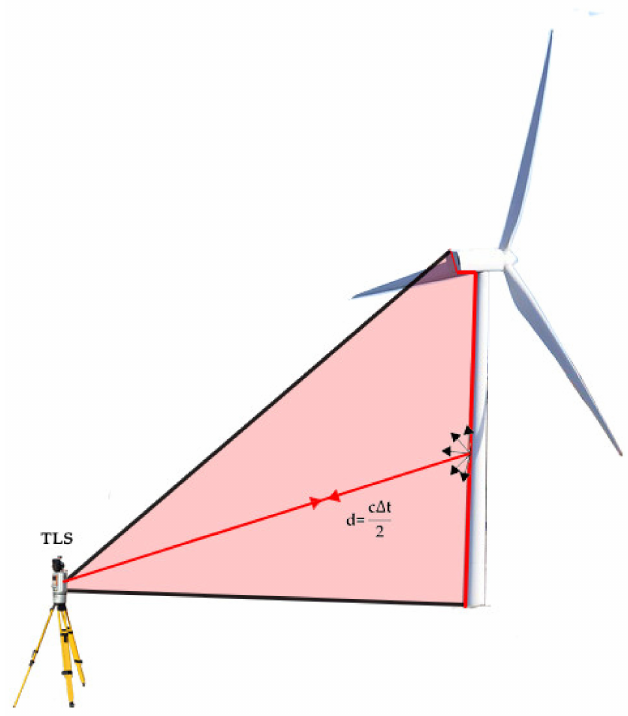
Figure 1. Sketch of the TLS functioning in line scan mode. The distance d is computed in Equation